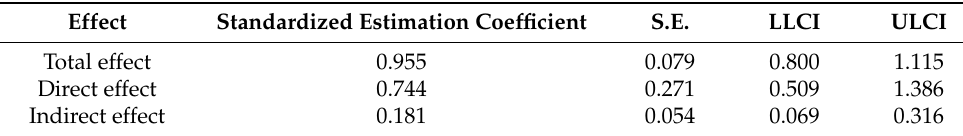
Table 7. The mediating effect of entrepreneurial self-efficacy on the positive impact of cognitive flexibility on entrepreneurship competence.